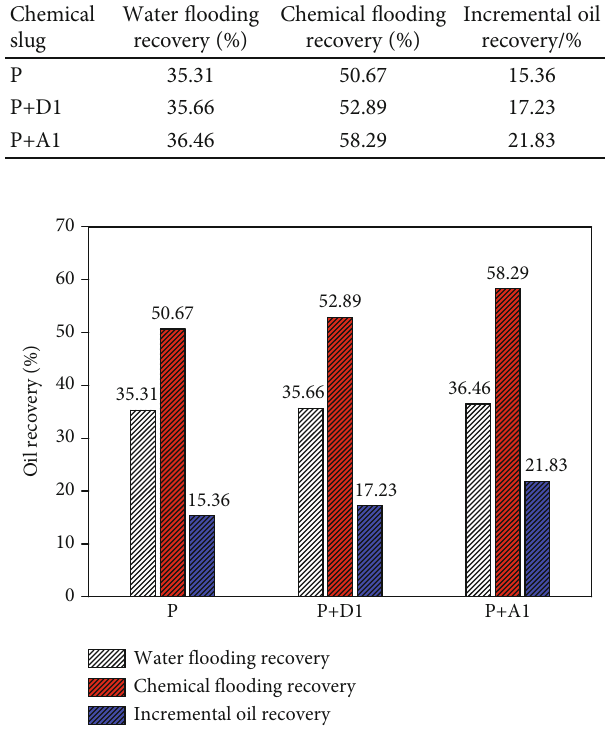
Figure 13: The incremental oil recovery results at di ff erent fl ooding stages for micromodel fl ooding.